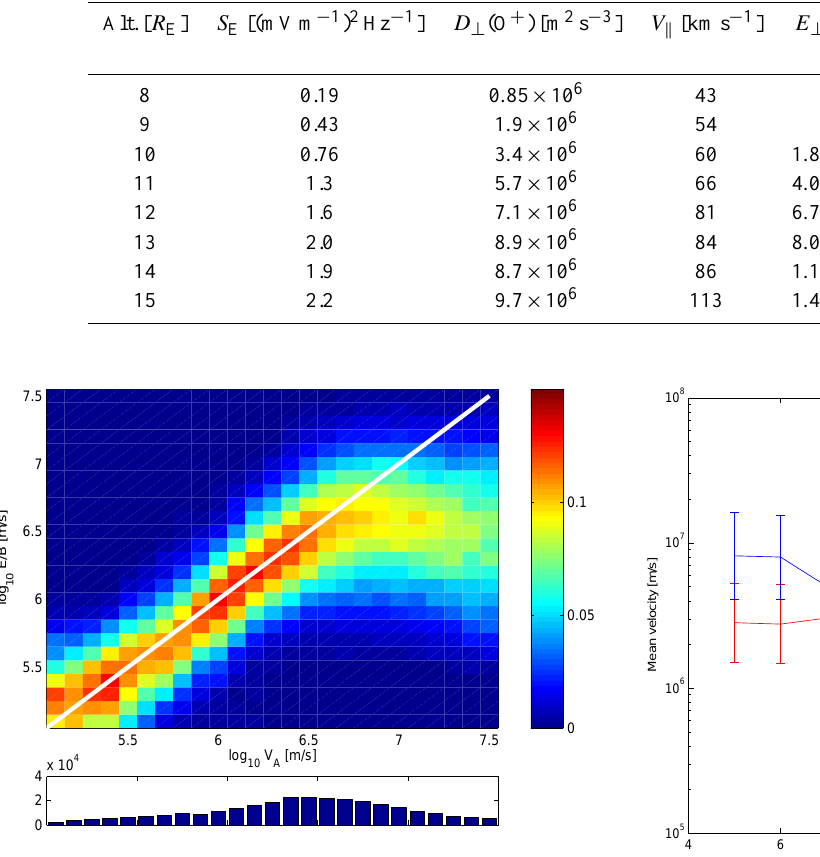
and summary of the test particle calculation.